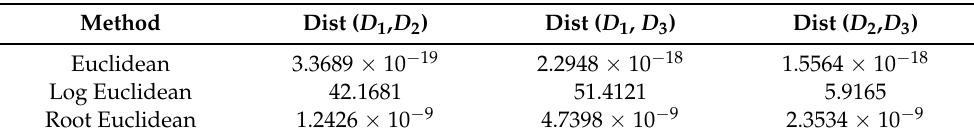
Table 4. The distances between the